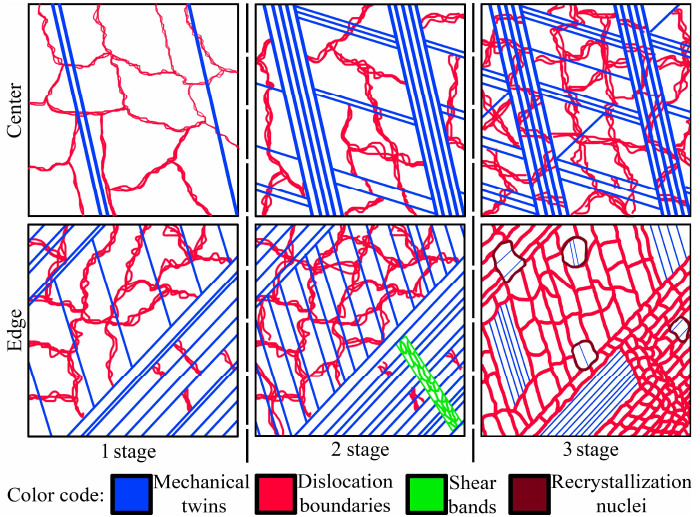
Figure 11. Scheme of structure evolution during swaging of the program steel. Notation: 1st stage— a 20% swaging reduction; 2nd stage—a 40–80% swaging reduction; 3rd stage—a 95% swaging reduction.